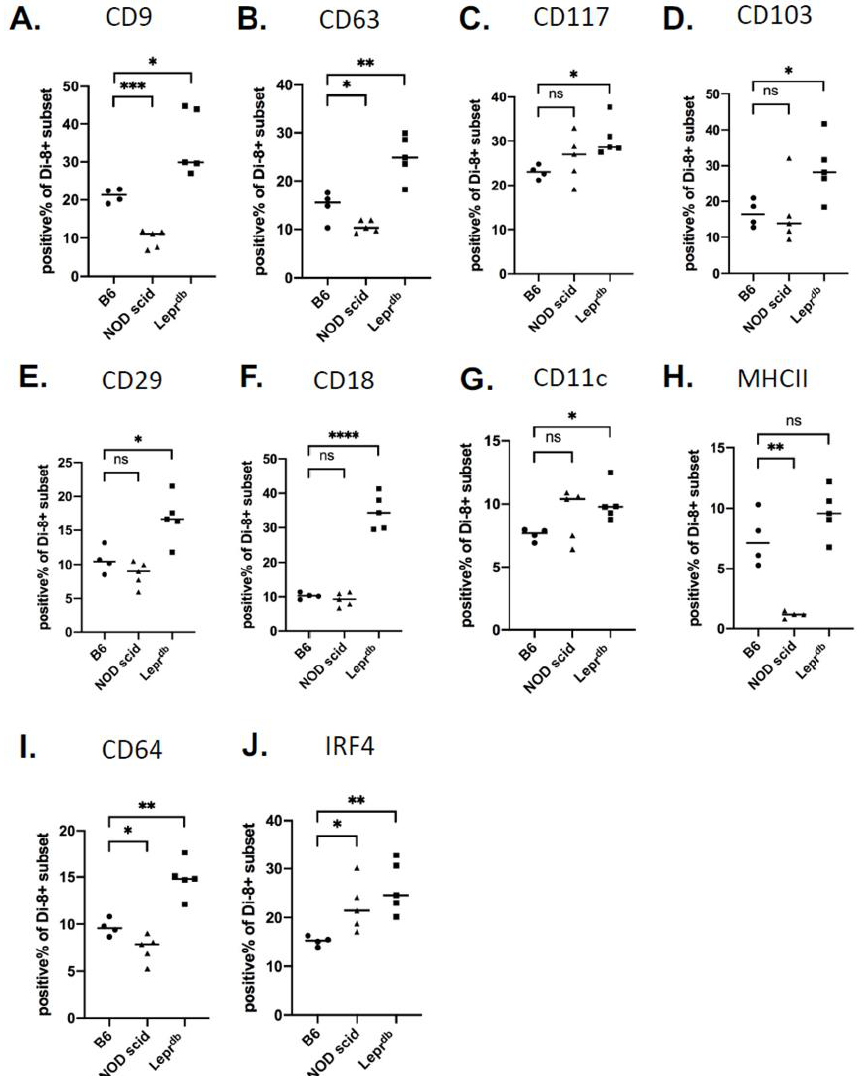
Figure 7. Analysis of EV proteins in wildtype, immunodeficient, and diabetic-obese mice. ( A – J ) Protein expression on EVs isolated and analyzed by vFC on C57 BL/6, NOD scid, and Lepr db (DB) mice. Data shown are mean ± SD. ( n = 4 for C57 BL/6 and n = 5 for NOD scid and DB mice group; * p < 0.05, ** p < 0.01, *** p < 0.001, and **** p < 0.0001, ns = not significant.